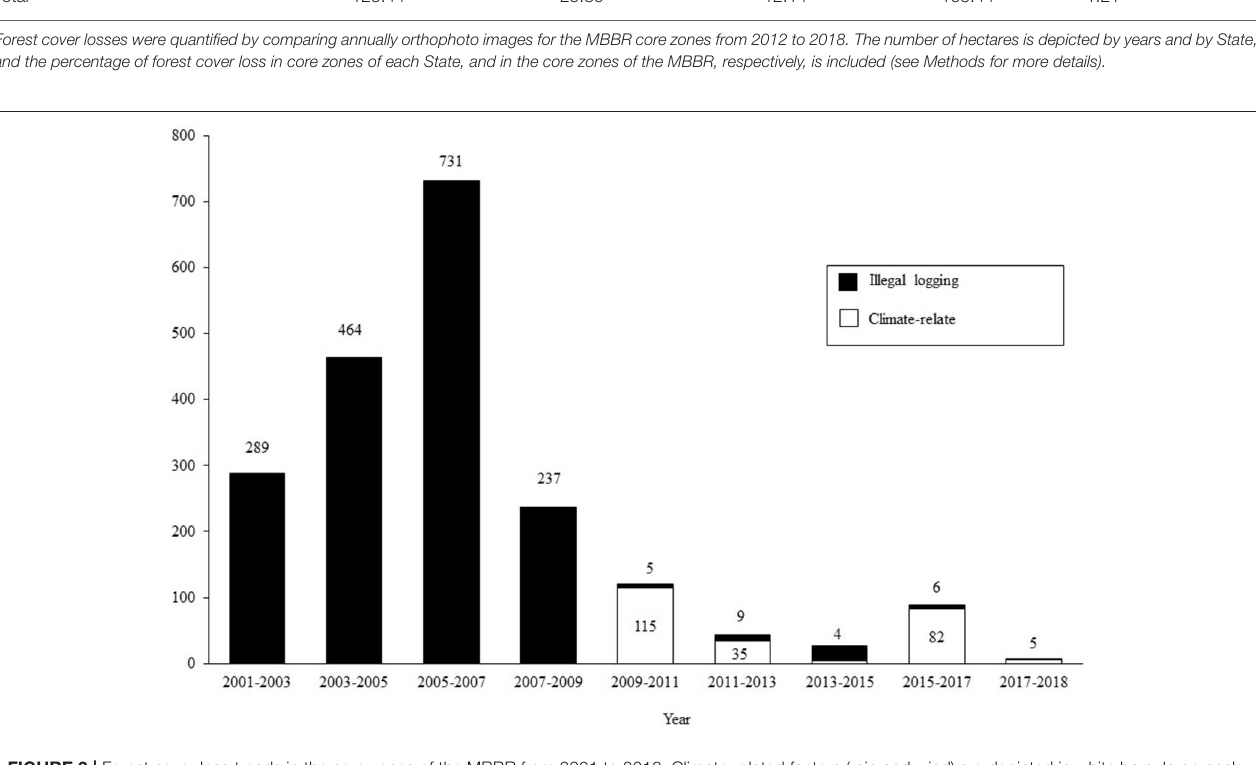
FIGURE 2 | Forest cover loss trends in the core zones of the MBBR from 2001 to 2018. Climate-related factors (rain and wind) are depicted in white bars; large-scale and small-scale illegal logging are depicted in black bars. The figure includes data from a previous study (2001–2012; see Vidal et al., 2013), and from this